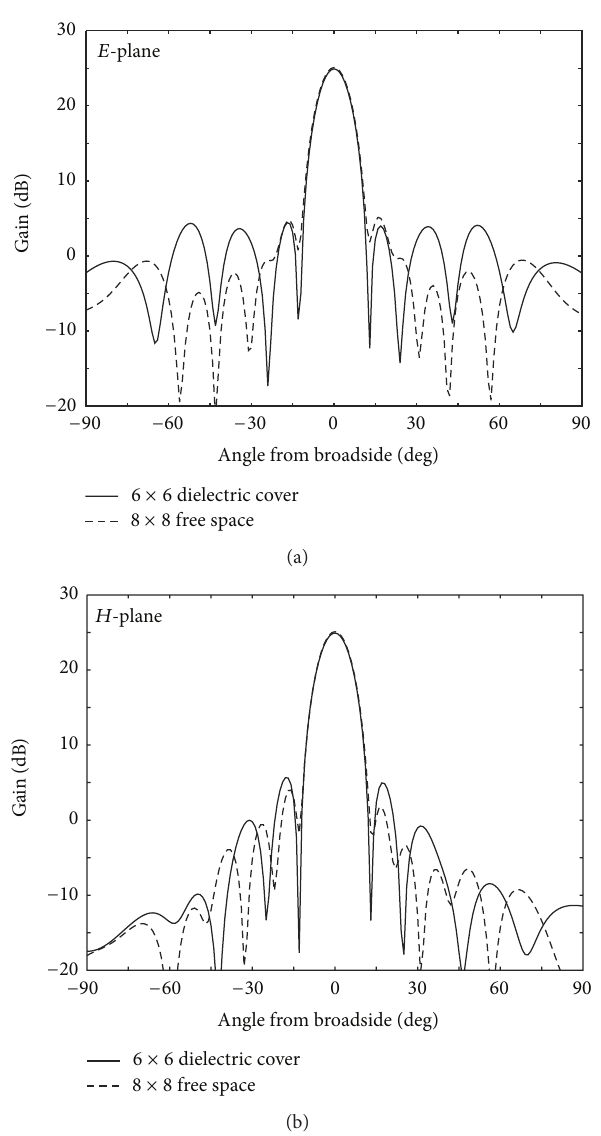
Figure 4: Simulated gain (HFSS) of 6 × 6 array with dielectric cover and 8 × 8 radiating in free space. 𝐷 𝑃 = 210